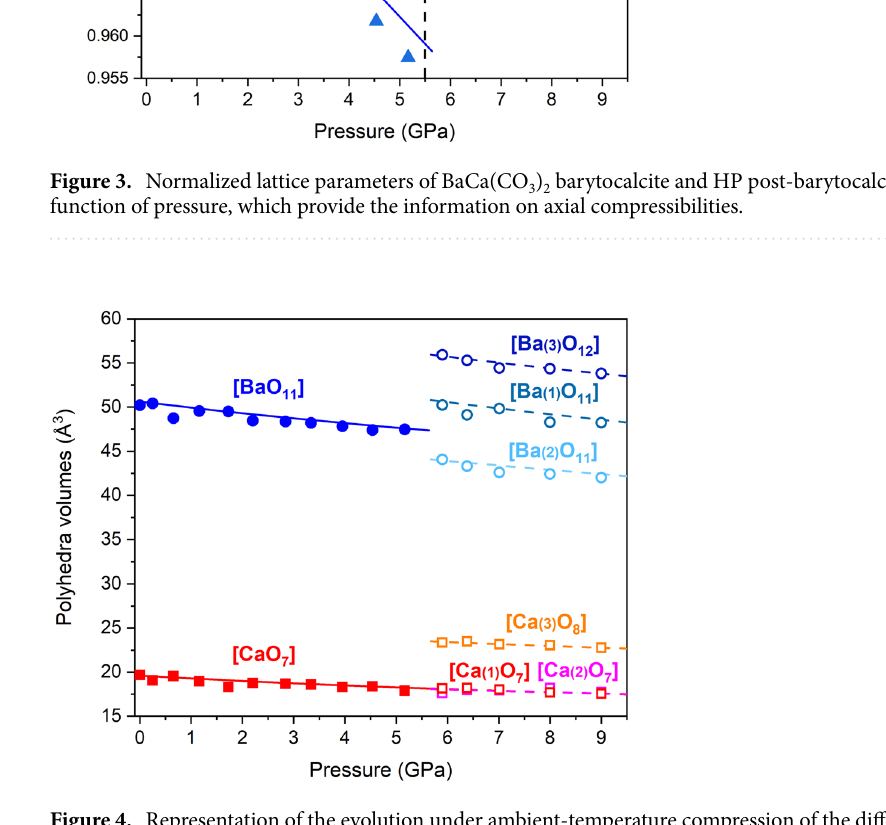
Figure 4. Representation of the evolution under ambient-temperature compression of the different cation- centered polyhedral unit volumes of BaCa(CO 3 ) 2 barytocalcite and HP post-barytocalcite phases according to single-crystal experiments and DFT calculations. At the transition (5.5 GPa), atoms rearrange changing their coordination geometries. ¼ of the Ba atoms (Ba(3)) and ½ of the Ca atoms (Ca(3)) increase their coordination number from 11 and 7 to 12 and 8,